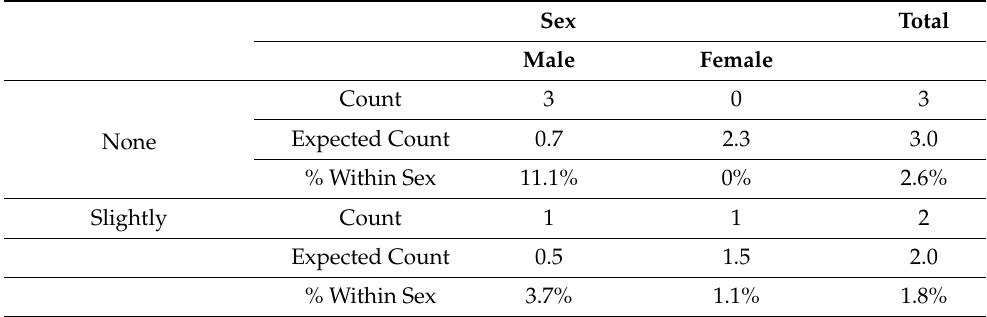
Table 5. Cross-tabulation results for improving personal health and quality of life by